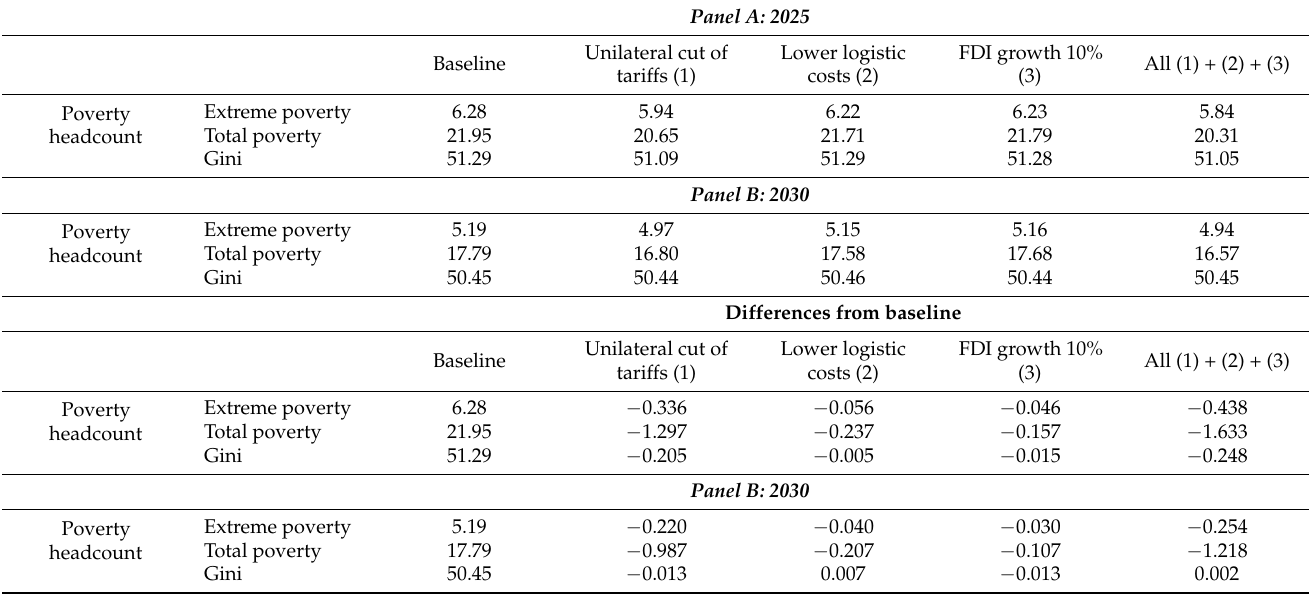
Table 9. Microsimulation impact on poverty and inequality Global Value Chain (GVC) reforms. Panel A: